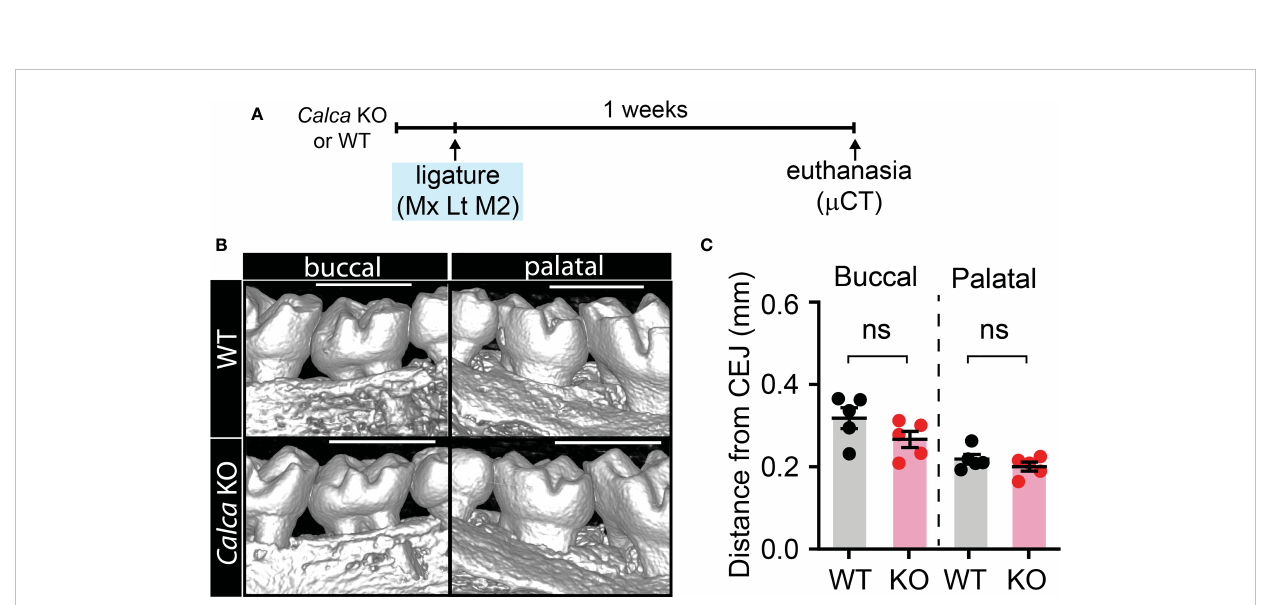
FIGURE 3 Knockout of Calca does not affect ligature-induced bone loss. (A) Time course of the experiments. (B) µCT analysis of bone loss one week after ligature placement in Calca Cre/Cre , in which Cre is knocked into the locus of Calca without expression of Calca . Scale bar, 1 mm. (C) Quanti fi cation of bone loss. N=5 per group. ns, not signi fi